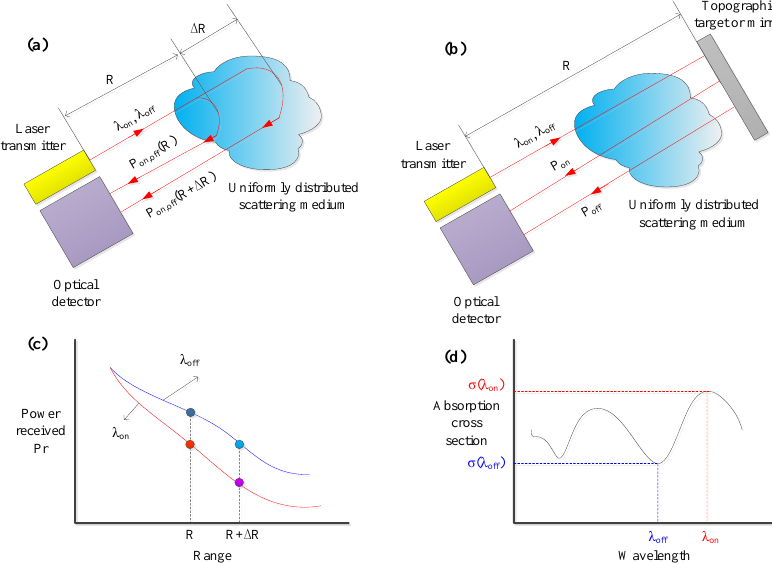
Figure 1. Differential Absorption LiDAR (DIAL) concept ( a ) range-resolved DIAL detection approach, ( b ) IPDA approach, ( c ) signal-reflection powers at wavelengths λ on , λ off and ( d ) absorption cross-section at wavelengths λ on , λ off .